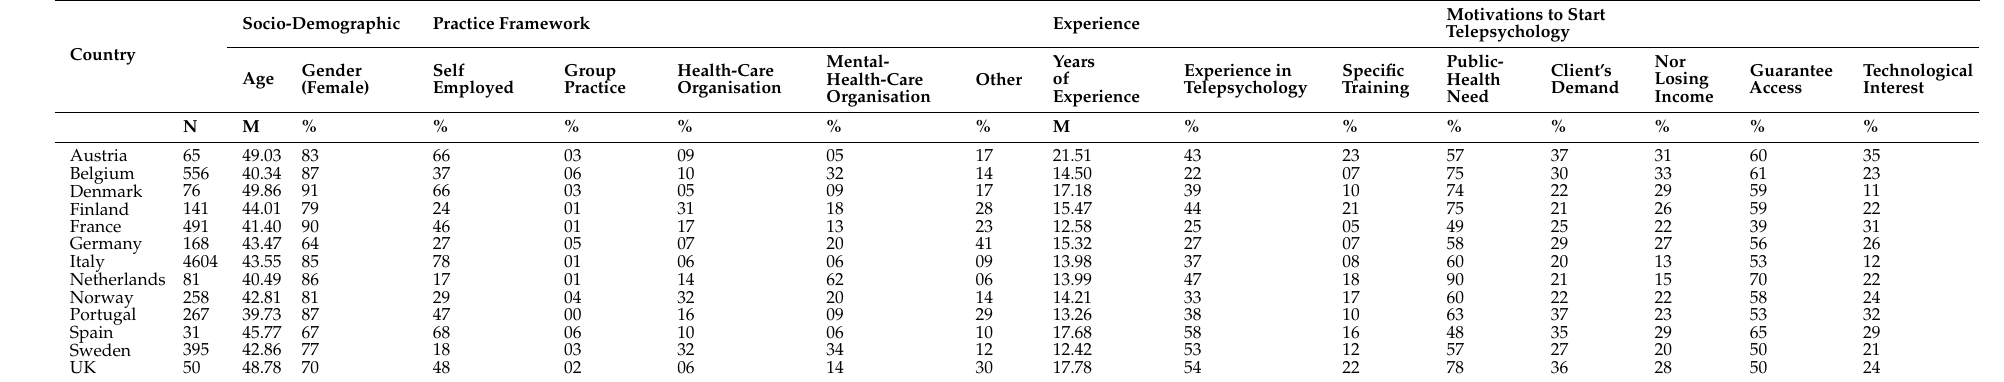
Table A1. Characteristics of respondents by country: number, average age, gender; type of practice, experience and type of motivation: percentages by